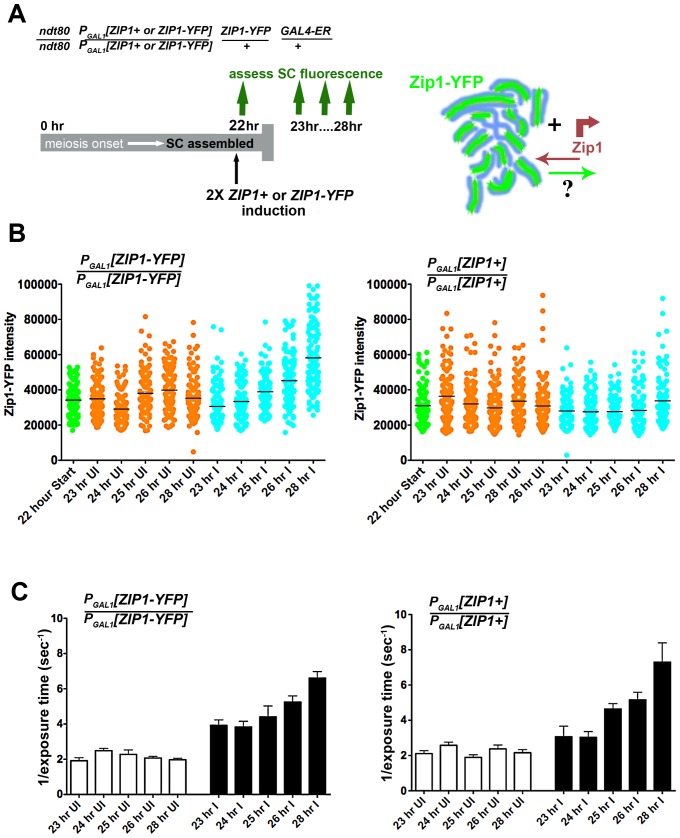
Zip1 subunits do not exit to the same extent that they enter the SC.Cartoon in (A) outlines the induction experiment designed to ask whether Zip1 subunits exit the full-length SC structure. Meiotic nuclei with full length SC built of ZIP1-YFP (green) are induced to express two copies of untagged ZIP1 (SM248) or ZIP1-YFP (SM240), at 22 hours of sporulation. SC intrinsic fluorescence is measured at multiple time points after induction. Scatterplots in (B) depict the fluorescence intensity (expressed in arbitrary units) of segments of SCs comprised predominantly of Zip1-YFP. Uninduced datapoints (orange) show a range of SC intrinsic fluorescence in the absence of induced ZIP1or ZIP1-YFP expression. Induced datapoints (blue) show ranges of SC fluorescence at specific time points after induction of two copies of ZIP1-YFP (left) or untagged ZIP1 (right), starting at 22 hours of sporulation (when most nuclei contain full-length SC). SC intrinsic fluorescence was measured in three adjacent 0.066 µm3 ROI volumes, placed over well-spread regions of SCs in multiple nuclei for each time point. Circles indicate values for individual ROI volumes; each time point contains 120 circles. Average fluorescence intensity of Zip1-YFP increased in the strain where ZIP1-YFP is induced (blue, left graph), while fluorescence intensity remained similar between time points when untagged ZIP1 is induced (blue, right graph). While several time points exhibited ranges that were significantly different from the earliest (23 hr) time point (for both uninduced and induced columns), only the 26 hr and 28 hr induced columns from the left graph display a two-tailed P value of <0.0001 (Mann-Whitney test). Horizontal bars indicate the mean. (C) Bar graphs show quantitation of Zip1 levels in SC, measured by intensity of anti-Zip1 antibody, from both strains in uninduced and induced conditions. SC growth in induced strains from both experiments increased to a similar extent despite whether Zip1-YFP (left) or Zip1 (right) was induced. As optimal exposure time of labeled Zip1 is indirectly proportional to the level of Zip1 in SCs, 1 divided by the average exposure time is shown. Optimal exposure times that maximize dynamic range were selected by the Softworx application in each case. Error bars indicate the standard error of the mean (n = 10). For (B) and (C), similar results were obtained from 2 independent time course experiments (one experiment is displayed here).